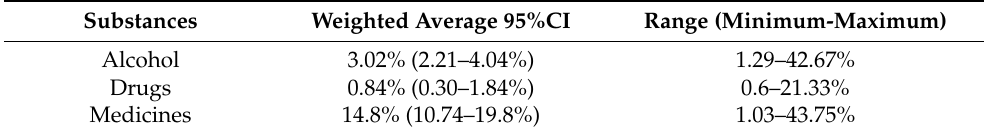
Table 4. The main descriptive statistics concerning the positivity